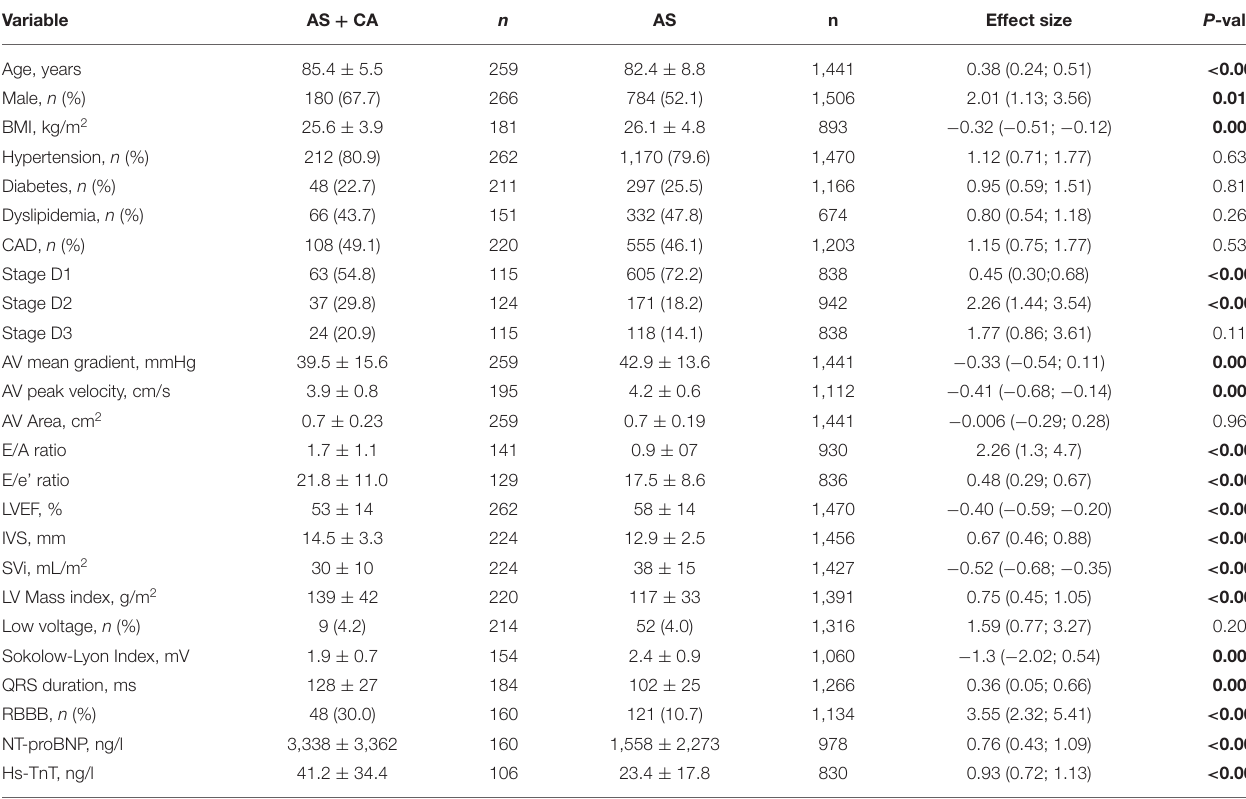
TABLE 1 | Characteristics of patients with AS with and without CA. Variable AS +